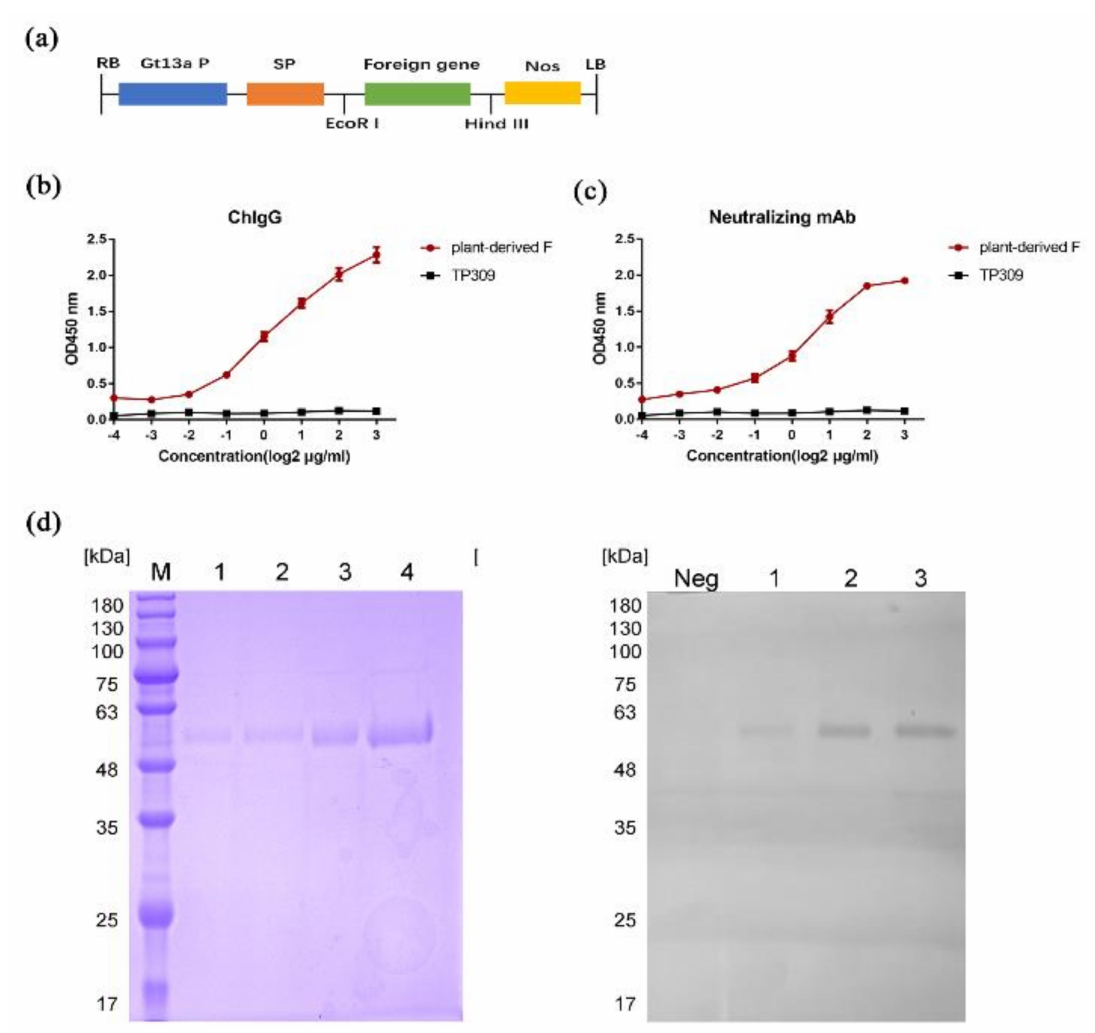
Figure 1. The production and purification of plant-made fusion (F) protein. ( a ) Schematic representation of the pCAMBIA 1300-F plasmid for the generation of transgenic rice lines. RB, right border; Gt13a promoter, rice seed storage protein glutelin gene promoter; SP, Gt13a signal peptide; Nos, nopaline synthase gene terminator; LB, left border. ( b ) Binding of chicken Newcastle disease (ND)-positive IgG to F protein was measured by ELISA (n = 3). ( c ) Binding of 13A5 mAb that recognizes the neutralizing epitope to F protein was measured by ELISA (n = 3). ( d ) SDS-PAGE electrophoresis and Western-blot of purified plant-produced F protein. Lanes 1–4 and F1–F2 were twofold serial dilutions of F protein. Neg was non-transgenic